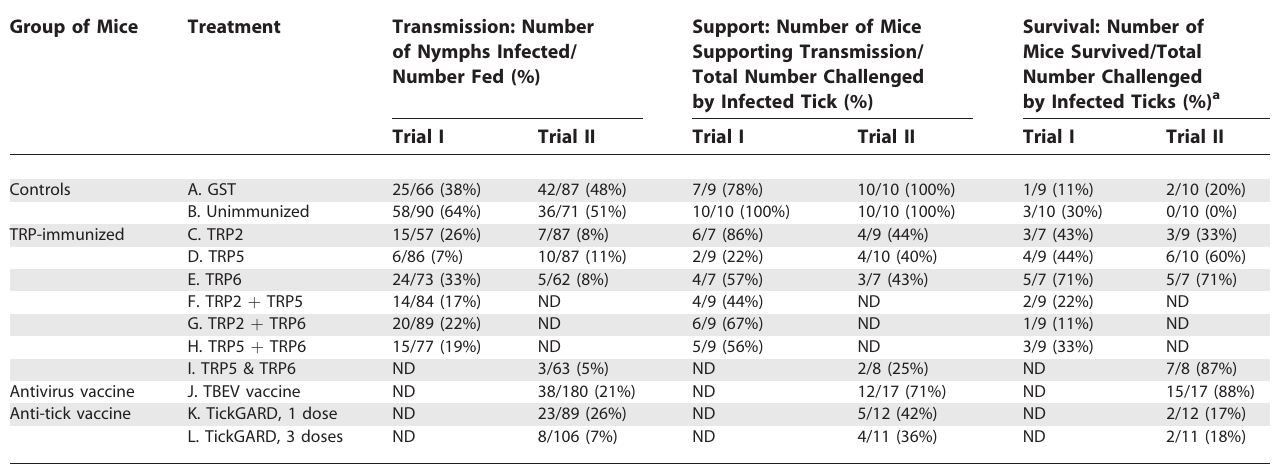
Table 1. Evaluation of the 64TRP Anti-Tick Vaccine in Protecting Mice against Transmission of a Lethal TBEV Infection by Its Natural Vector, I. ricinus, and Comparison with Commercial Antiviral (FSME-IMMUN) and Anti-Tick (TickGARD) Vaccines Group of